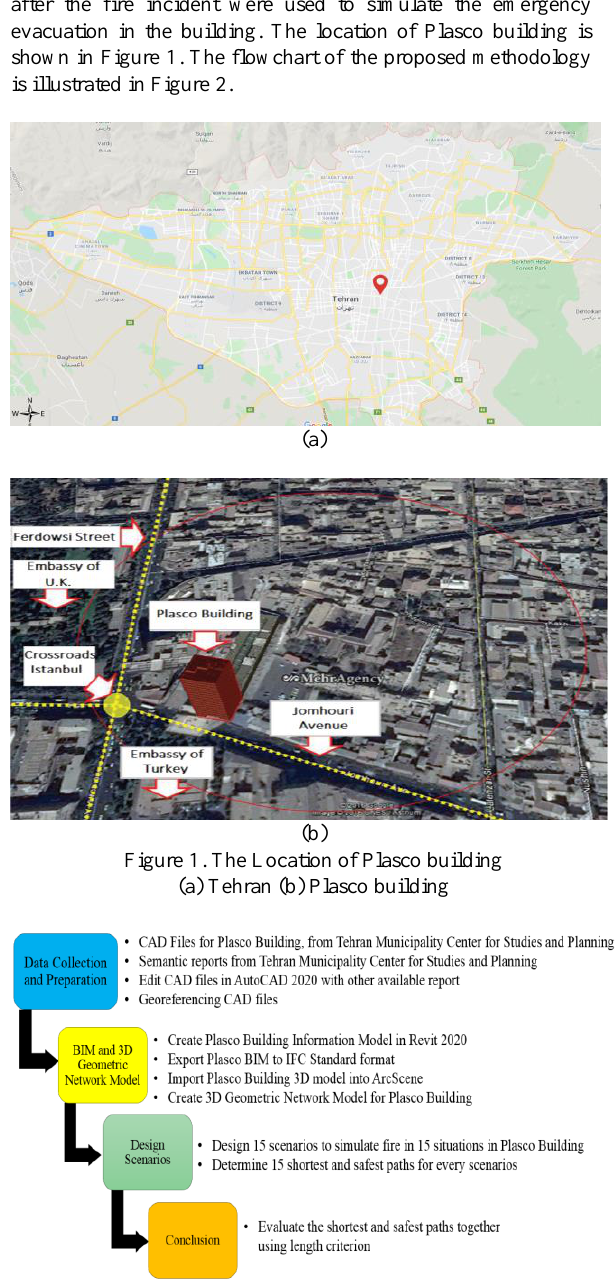
Figure 2. The flowchart of the proposed